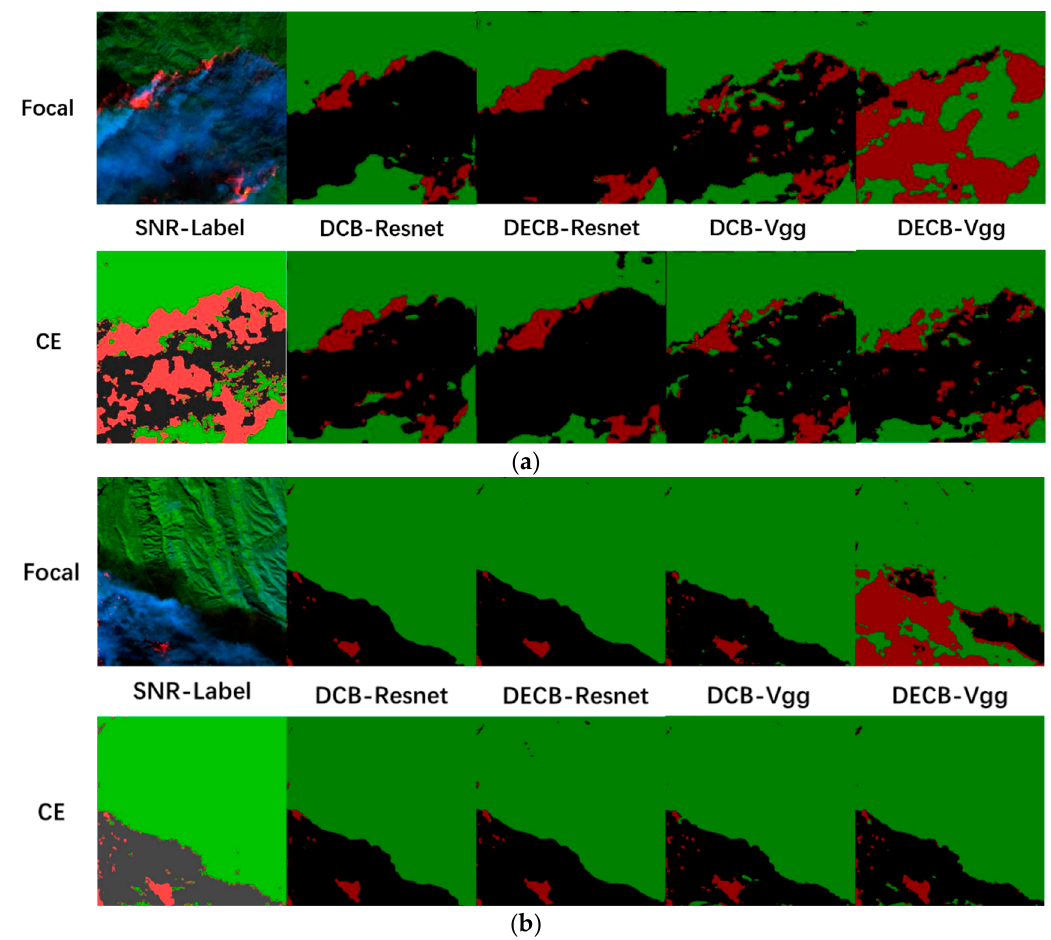
Figure 13. Example of segmentation results for the forest fire burning area dataset: ( a ) sample of the large burning area, and ( b ) sample of the small burning area.